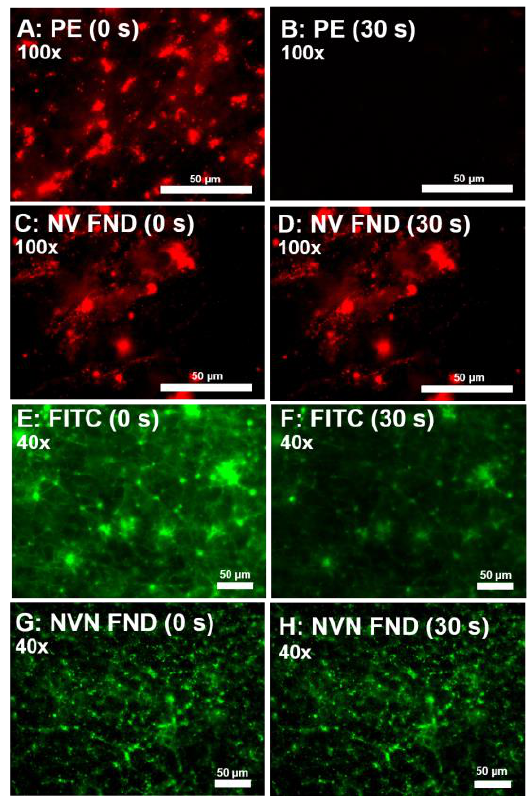
Figure 5. ( A ) Image of FITC-labeled clot at 10 × prior to investigation at higher magnification. ( B ) Image of FITC-labeled clot after viewing several areas at higher magnification (40 × ) and then reimaging at 10 × , showing the appearance of “holes” formed due to FITC bleaching (stars). Scale bars 100 µ m. Ex/Em: 470/488LP.